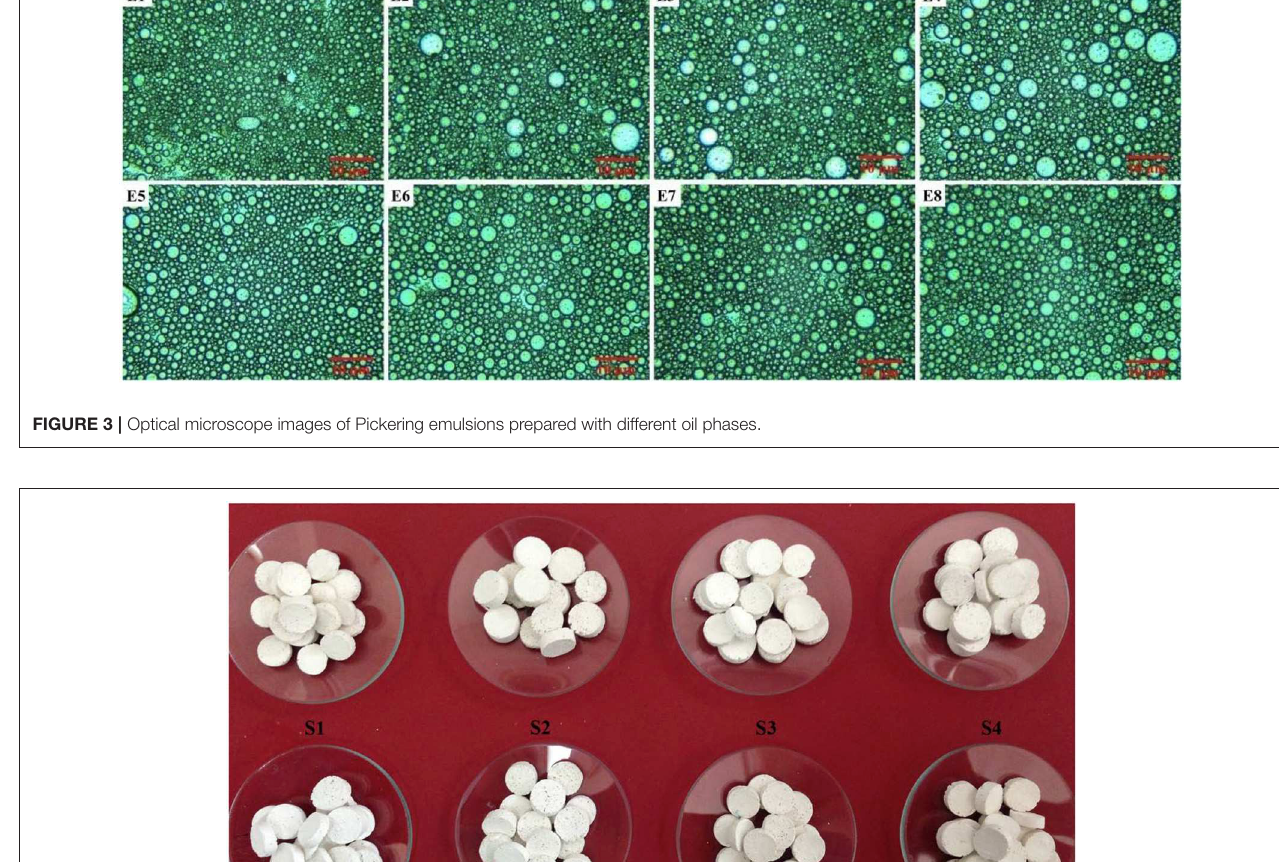
successful in forming a porous structure inside hydrogels during the polymerization and post-treatment. The elution of the oil phase contributed to the formation of macropores, while the thinner monomer layer between neighboring droplets resulted in open pore throats between neighboring macropores (Xu et al., 2016; Wang et al.,